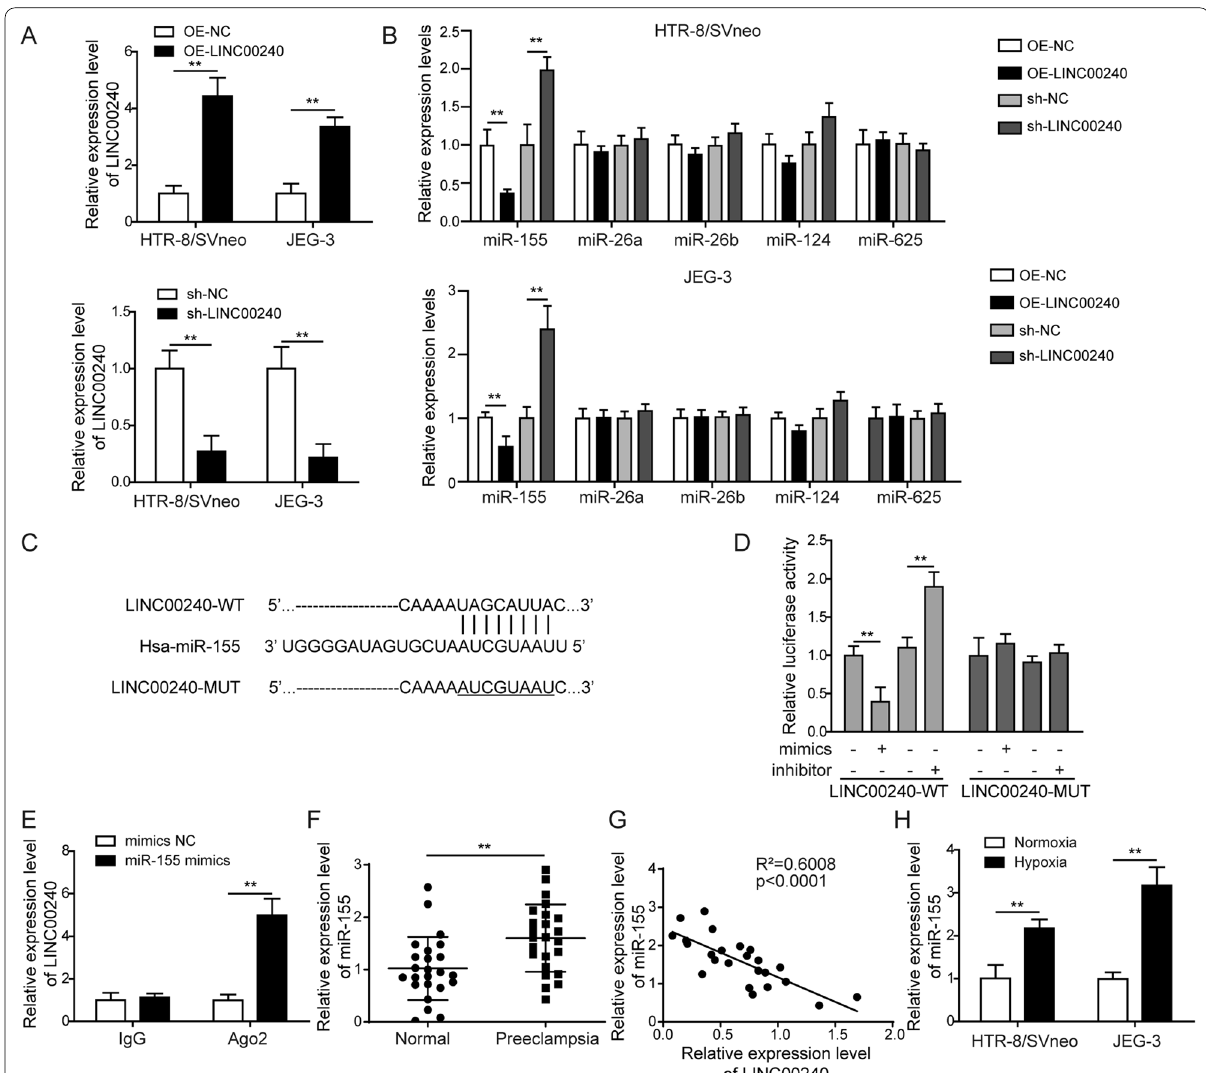
Fig. 3 LINC00240 negatively regulates miR‑155 expression in trophoblasts. A qPCR measurement on LINC00240 expression levels in HTR‑8/SVneo and JEG‑3 cells with LINC00240 overexpression (OE‑LINC00240) or LINC00240 knockdown (sh‑LINC00240). B qPCR measurement on miR‑155, miR‑26a, miR‑26b, miR‑124, and miR‑625 expression levels in HTR‑8/SVneo and JEG‑3 cells with LINC00240 overexpression or knockdown. C Bioinformatics analysis of the possible binding sites between LINC00240 and miR‑155. D Measurement of luciferase activities of wild type (WT) or mutated (MUT) LINC00240 using dual luciferase assay with enhanced or inhibited miR‑155 expression. E Detection of direct binding between LINC00240 and miR‑155 using RIP assay. F qPCR measurement on miR‑155 expression levels in placenta tissues from preeclampsia patients (n and normal pregnant women (n 24). G A correlation analysis between LINC00240 and miR‑155 levels in placenta tissues from preeclampsia = patients (n 24). H qPCR measurement on miR‑155 expression levels in HTR‑8/SVneo and JEG‑3 cells cultured in a normal or hypoxic condition. All = the experiments were repeated at least three times. * P < 0.05 and ** P <